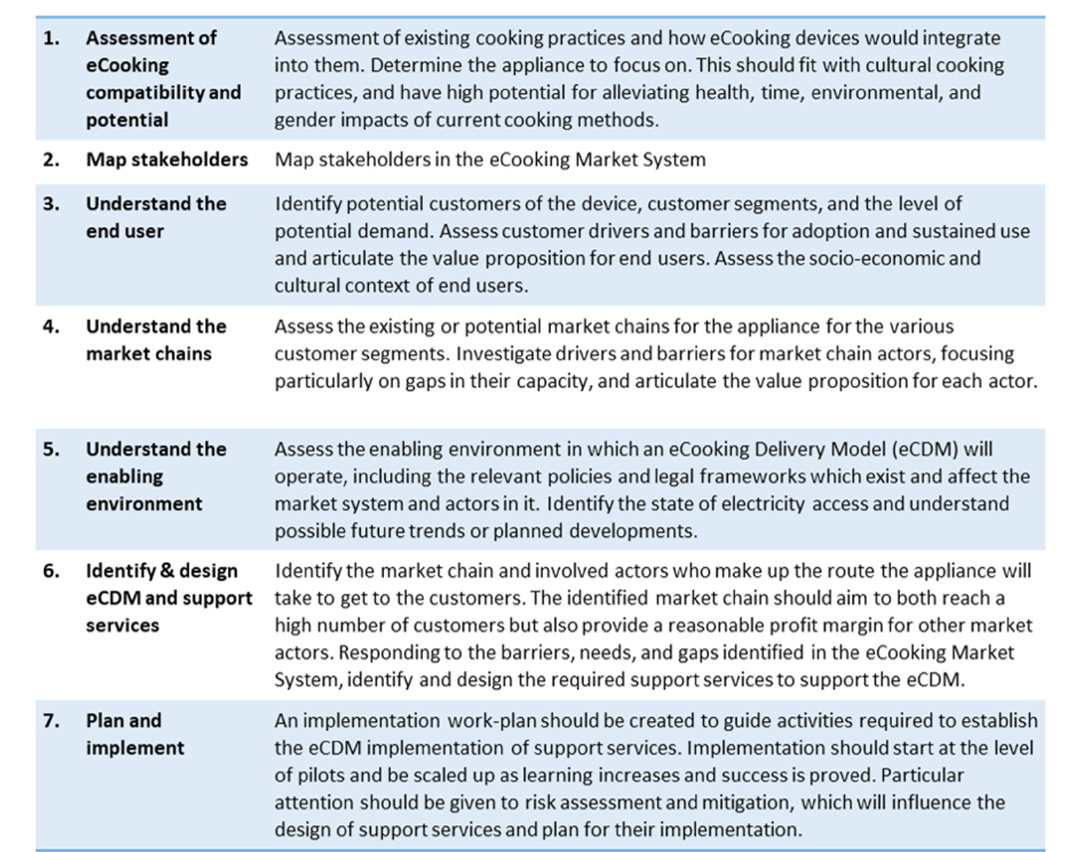
Figure 2. Seven-step design approach for eCDMs and support services.